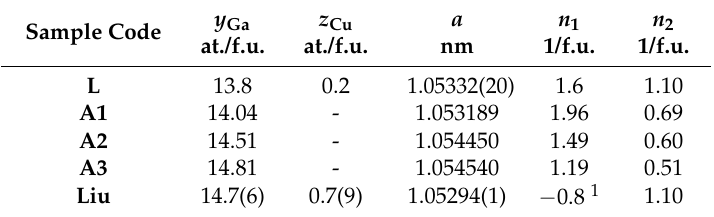
Table 3. Ga and Cu contents ( y Ga , z Cu ) in samples for comparisons, which are used for estimation of the charge carrier concentration n 1 by the Zintl rule; n 2 is derived from Equation (1) (see text). y Ga z Cu a n 1 n 2 Sample Code at./f.u. at./f.u. nm 1/f.u.